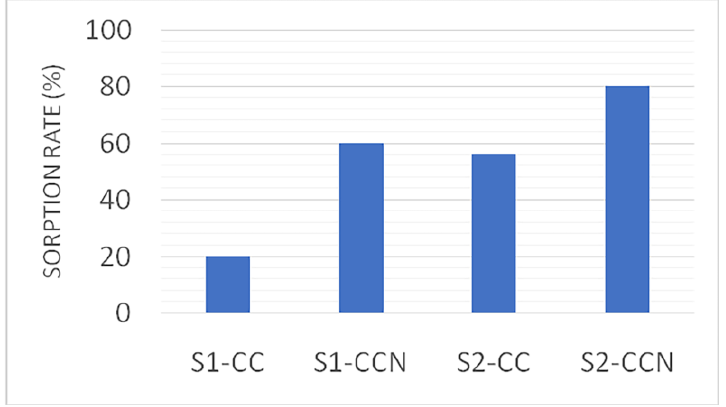
Figure 2. The sorption rate of curcumin dyes on palygorskite type hosting matrices.